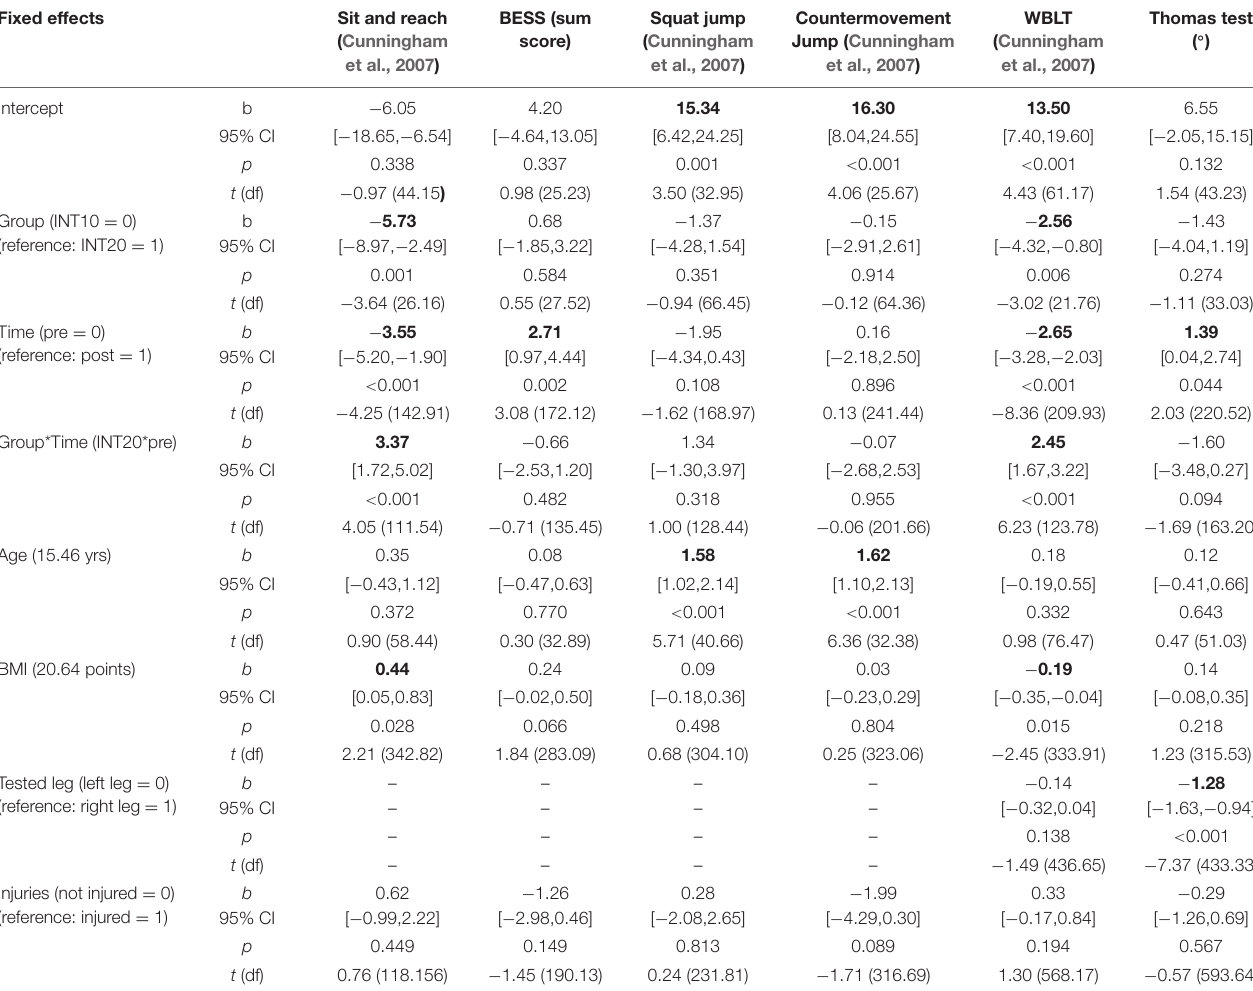
TABLE 2 | Group wise comparison of INT10 and INT20 expressed as estimater (b) and 95% Confidence interval (95% CI) considering pre and post measurement including confounder analysis for age, BMI, tested leg and injured or not injured. Fixed